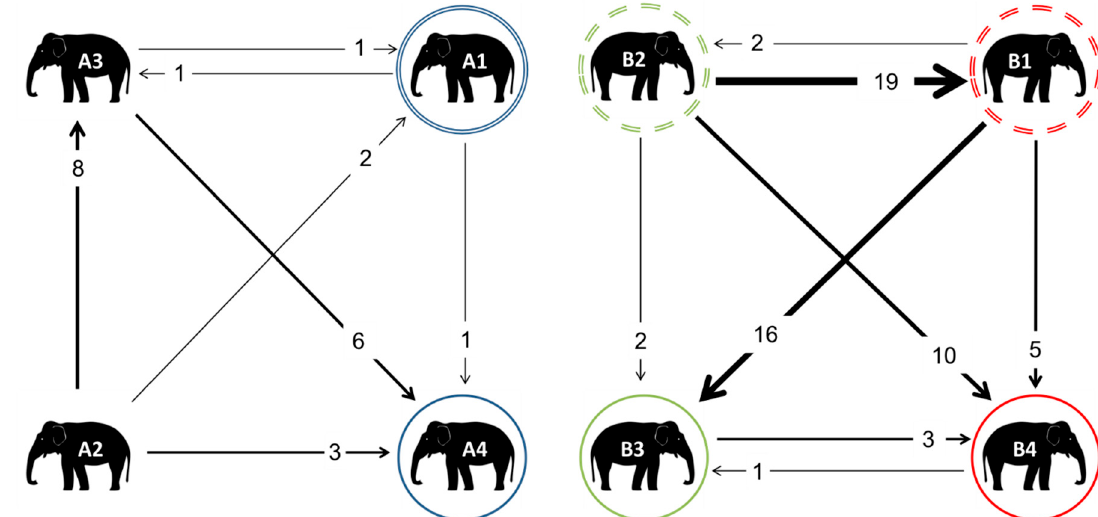
Figure 7. Weighted digraphs based upon the non-contact displacement for the elephants at Zoo A ( a ) and Zoo B ( b ). The double circles indicate mothers, whilst matching coloured solid circles indicate their daughters. In Zoo B, all of the individuals were related: dashed circles indicate siblings; their daughters B3 and B4 are therefore cousins, and nieces to the other sibling.